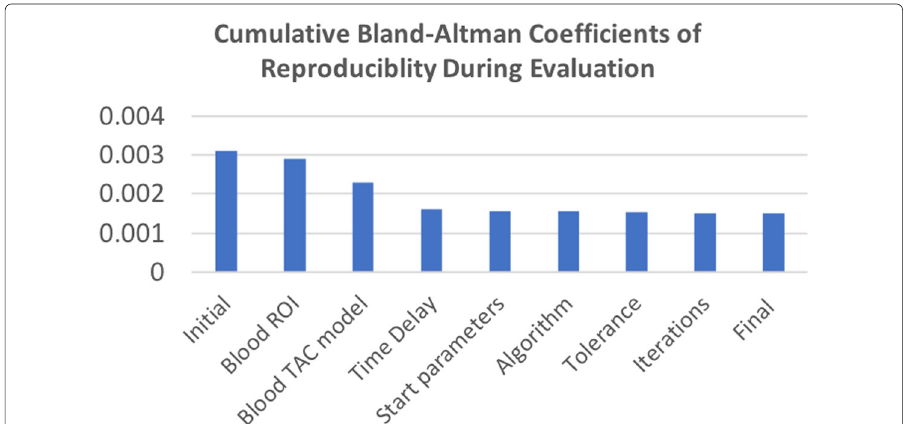
Fig. 5 Cumulative Bland-Altman coefficients of reproducibility for K im during the evaluation of pipeline A and B. Pipeline B was altered at each stage to improve the agreement in K im , each value represents the cumulative effect of all preceding stages. ROI =